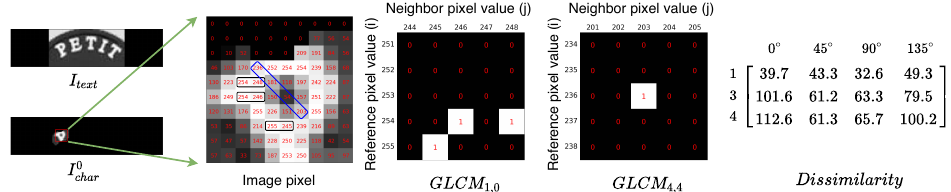
Figure 5. An illustration of how the GLCM is computed. A character image is cropped from the text image; 256 gray-levels are represented by numerical values from 0 to 255. Pixel values are displayed in the non-zero area of the character. As shown in the image pixel, there are three instances of a reference pixel with a neighbor pixel: ∆ x = 1, ∆ y = 0, θ = 0 ◦ (indicated in three black rectangles). In addition, there is an instance: ∆ x = 4, ∆ y = 4, θ = 45 ◦ (indicated in the blue